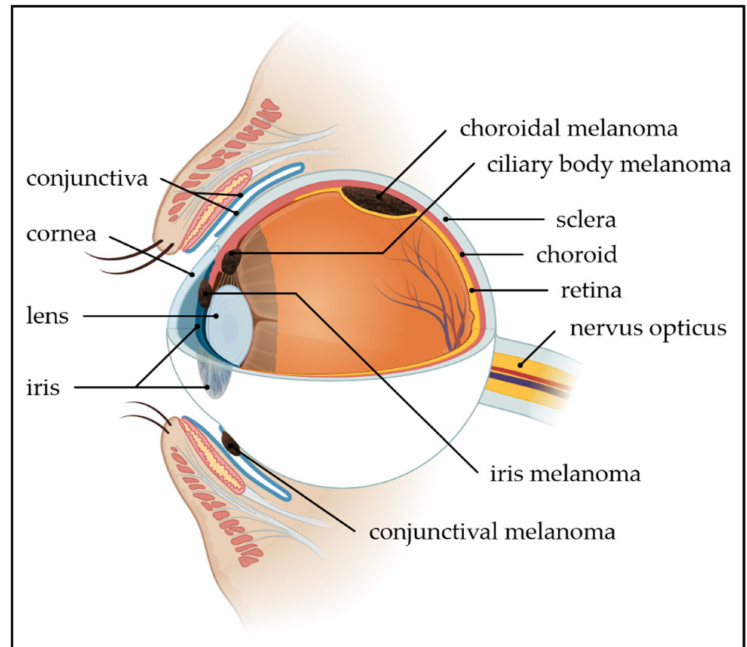
Figure 1. Anatomic location of melanomas of the ocular region. Melanomas of the ocular region arise from melanocytes in the conjunctiva (5%) or the uvea (95%). Of the uveal melanomas, approximately 90% arise in the choroid, 5% in the ciliary body, and 5% in the iris. (Figure was created with PowerPoint and